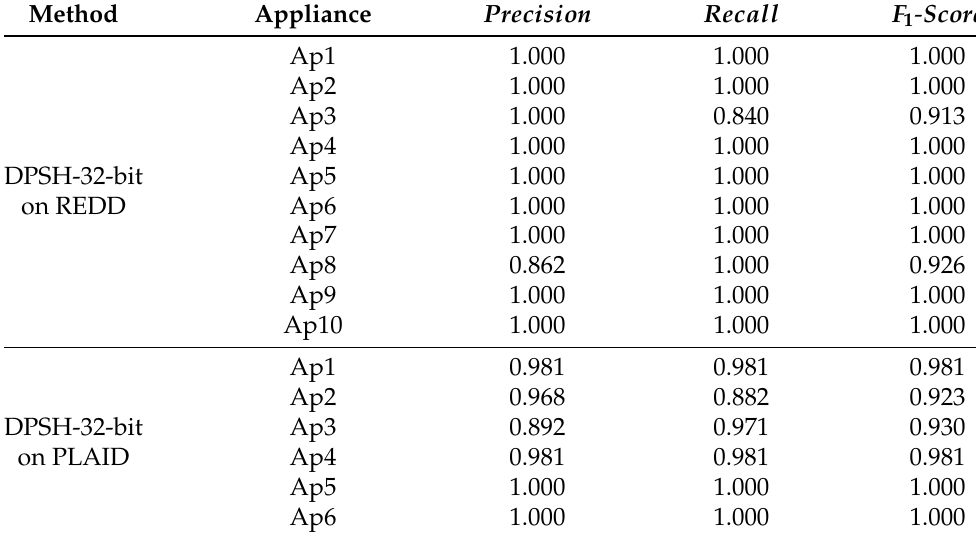
Figure 6. It ensures that the Hamming distance between codes of different labels is as